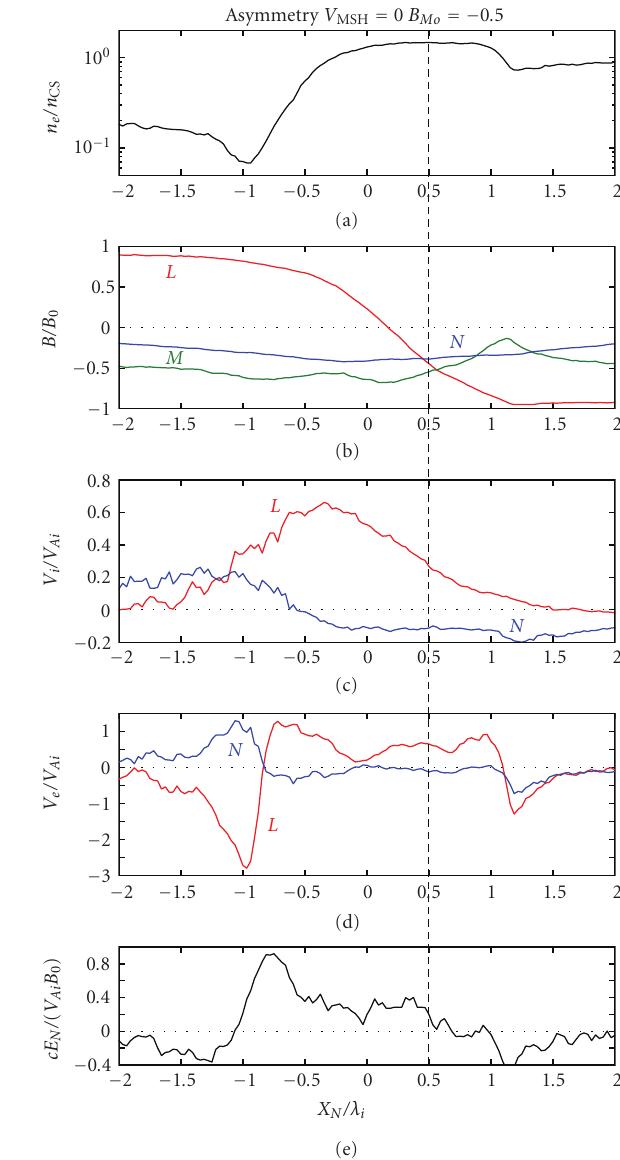
Figure 12: The cuts along the N -axis of the high-density structure at L = 4. In the same format as Figure 5 except that ion and electron flows are now shown in Panels (c) and (d), respectively. The high-density peak (at N = 0 . 5) is between the two density dips (at N = − 0 . 85 and 1.27) and is on the magnetosheath side of the region showing E N >